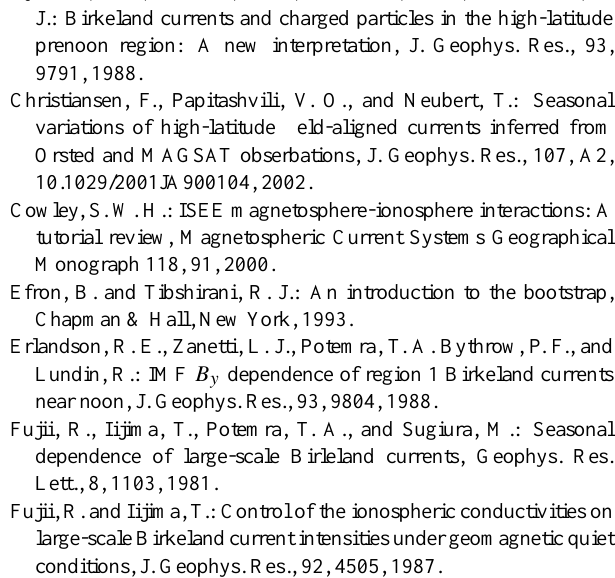
while c-R1 mainly flows in the closed field line region. The source of the R1-R0 pair in Ohtani et al. (1995) (Fig. 11 in their paper) was assumed to exist on open field lines, thus it may correspond to the source of